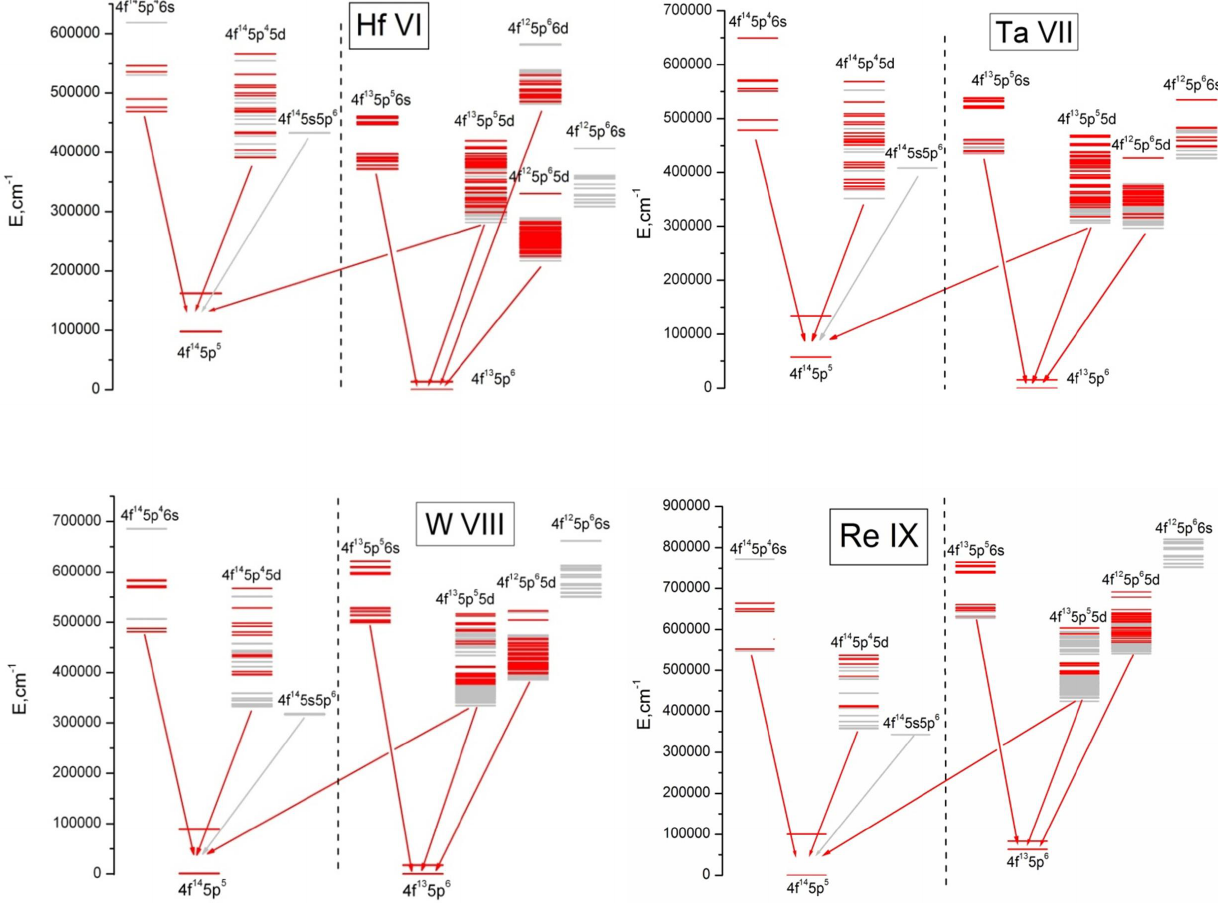
Figure 2. Energy levels of low-lying configurations of Hf VI, Ta VII, W VIII, and Re IX. Red horizontal bars show levels established in this work. Calculated positions of unknown levels are shown in grey colour. Dashed vertical lines divide systems formed by excitation of the two lowest configurations 4f 14 5s 2 5p 5 and 4f 13 5s 2 5p 6 (the subshell 5s 2 is omitted from the configuration names except for 4f 14 5s5p 6 ). Arrows indicate electron dipole transitions between the